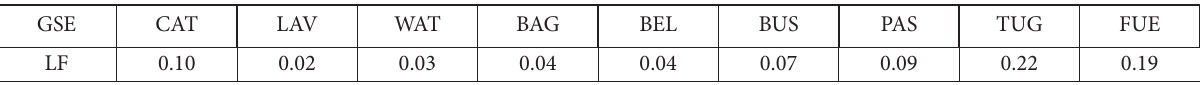
Table 10. Reference models for calculation (source: U.S. Department of Transportation, 2019) GSE GPU CAT BAG Model TLD 400Hz Power [kW]